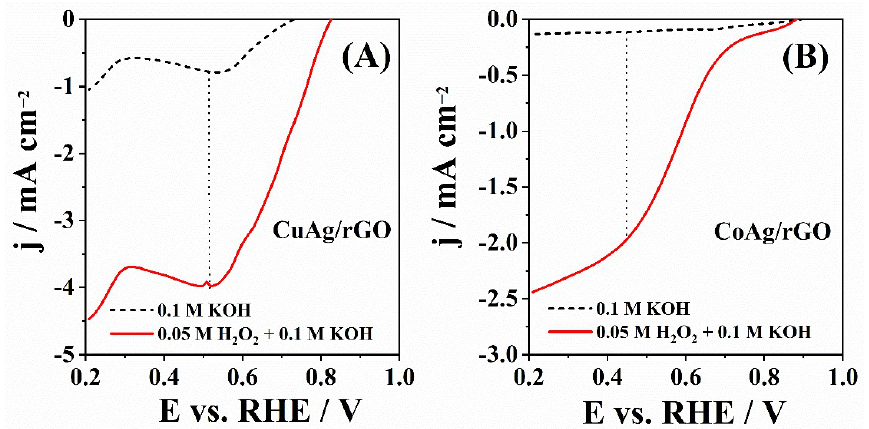
Figure 7. LSVs of CuAg/rGO ( A ) and CoAg/rGO ( B ) electrocatalysts recorded at 20 mV s − 1 in N 2 -saturated 0.1 M KOH solution without (–) and with (-) 0.05 M H 2 O 2 . Table 1. Comparison of ORR parameters of CuAg/rGO and CoAg/rGO electrocatalysts with the activity of similar materials reported in the